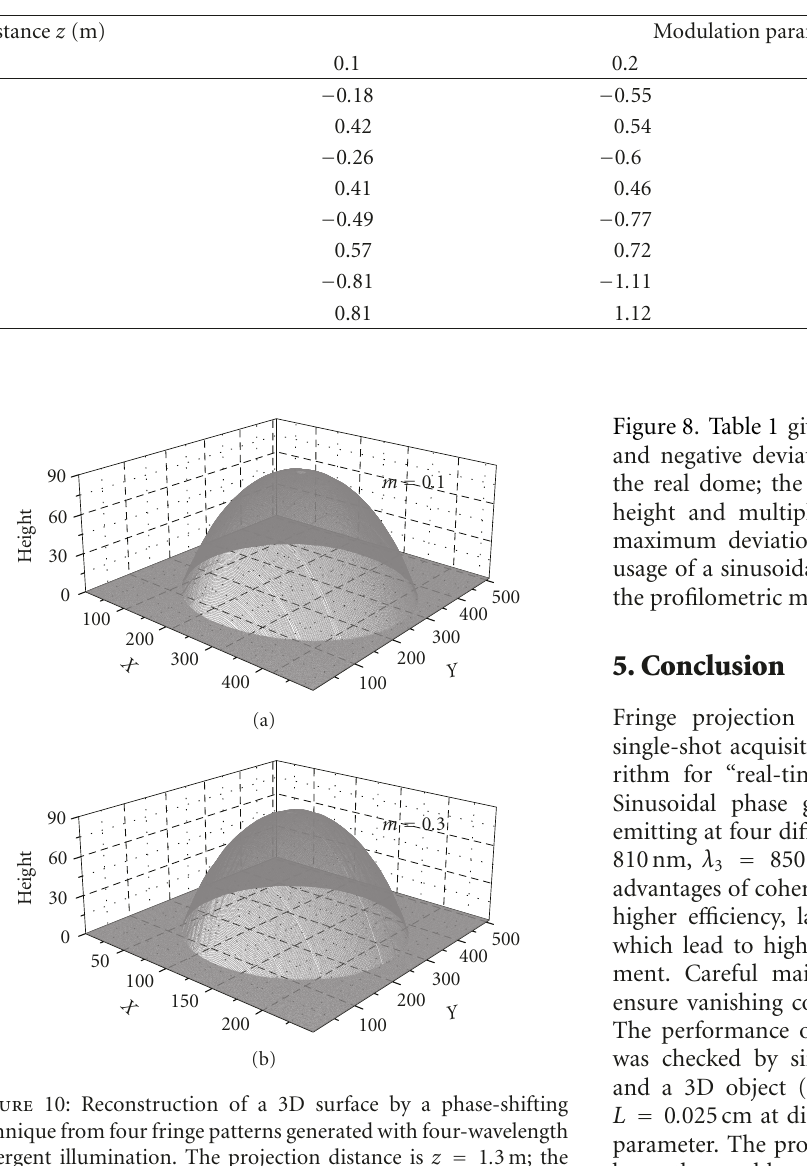
Table 1: Maximum negative and positive deviations in % from the dome height.